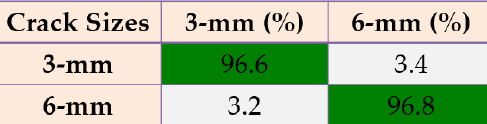
Figure 25. The average of crack size (3 mm and 6 mm) diagnosis using the combination of ALSGL- SBI and SVM approach for all abnormal conditions.